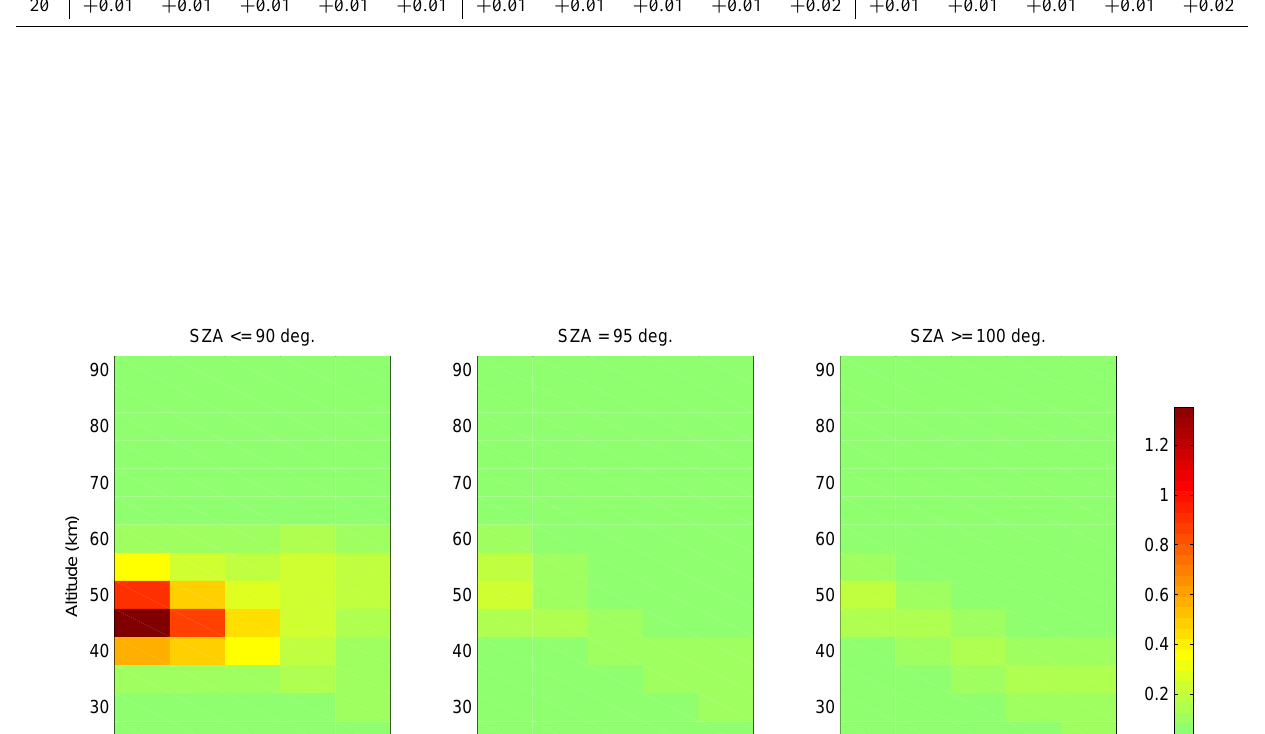
/Q for October 3